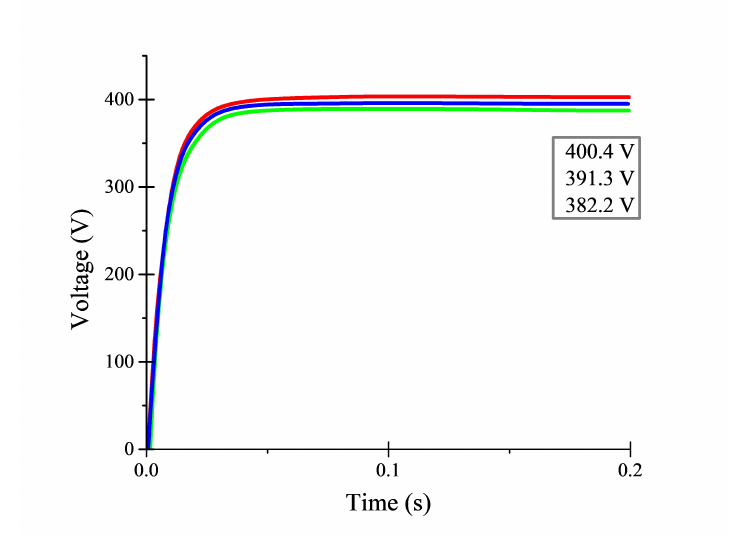
Figure 11. Port II: ( a ) input AC 10 kV, ( b ) line voltage ( c ), phase voltage and ( d ) output constant 400 V.